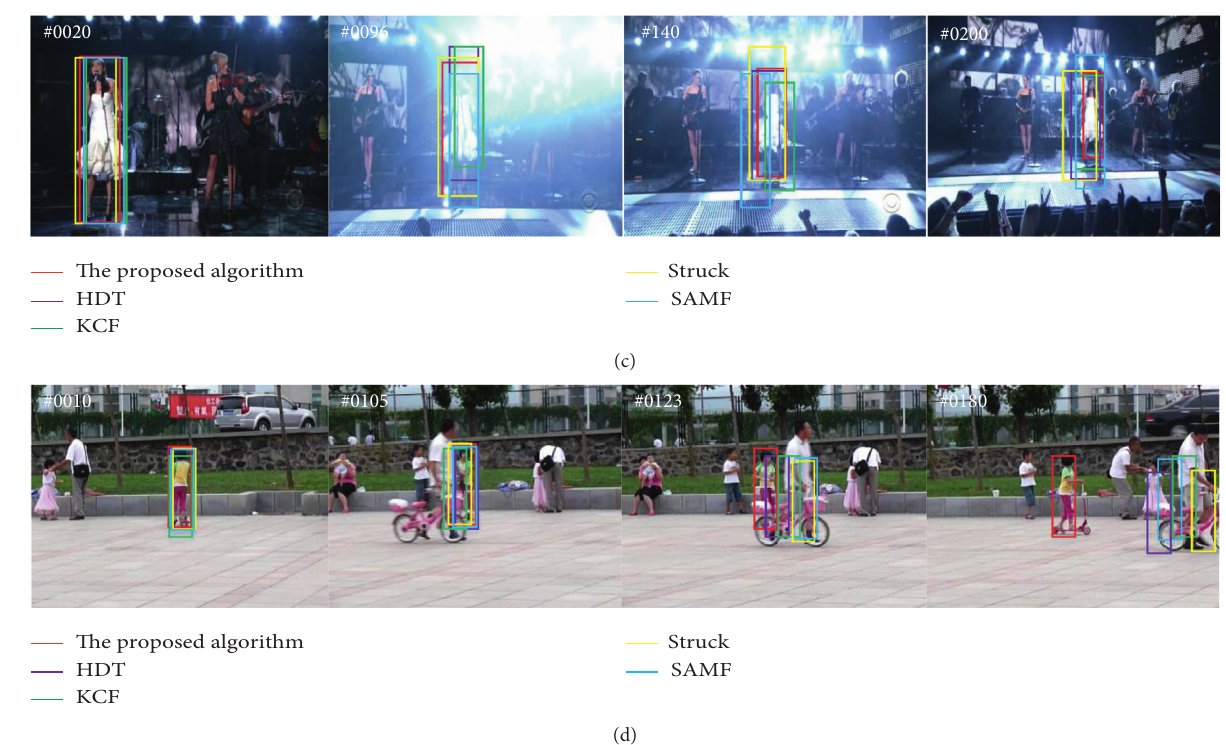
Figure 9: Qualitative comparison between the proposed tracker and other representative trackers (KCF [11], HDT [25], Struck [7], and SAMF [22]) on some visual object tracking sequences. (a) Matrix video sequence. (b) Dog video sequence. (c) Singer1 video sequence. (d) Girl2 video sequence. The proposed model provides consistent results in challenging scenarios, such as occlusions, illumination variation, fast motion, and background